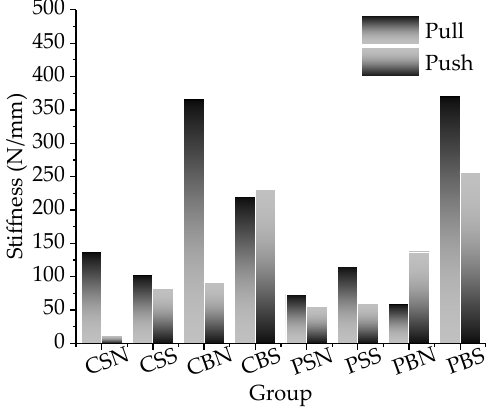
Figure 7. Initial stiffness of the test specimens.